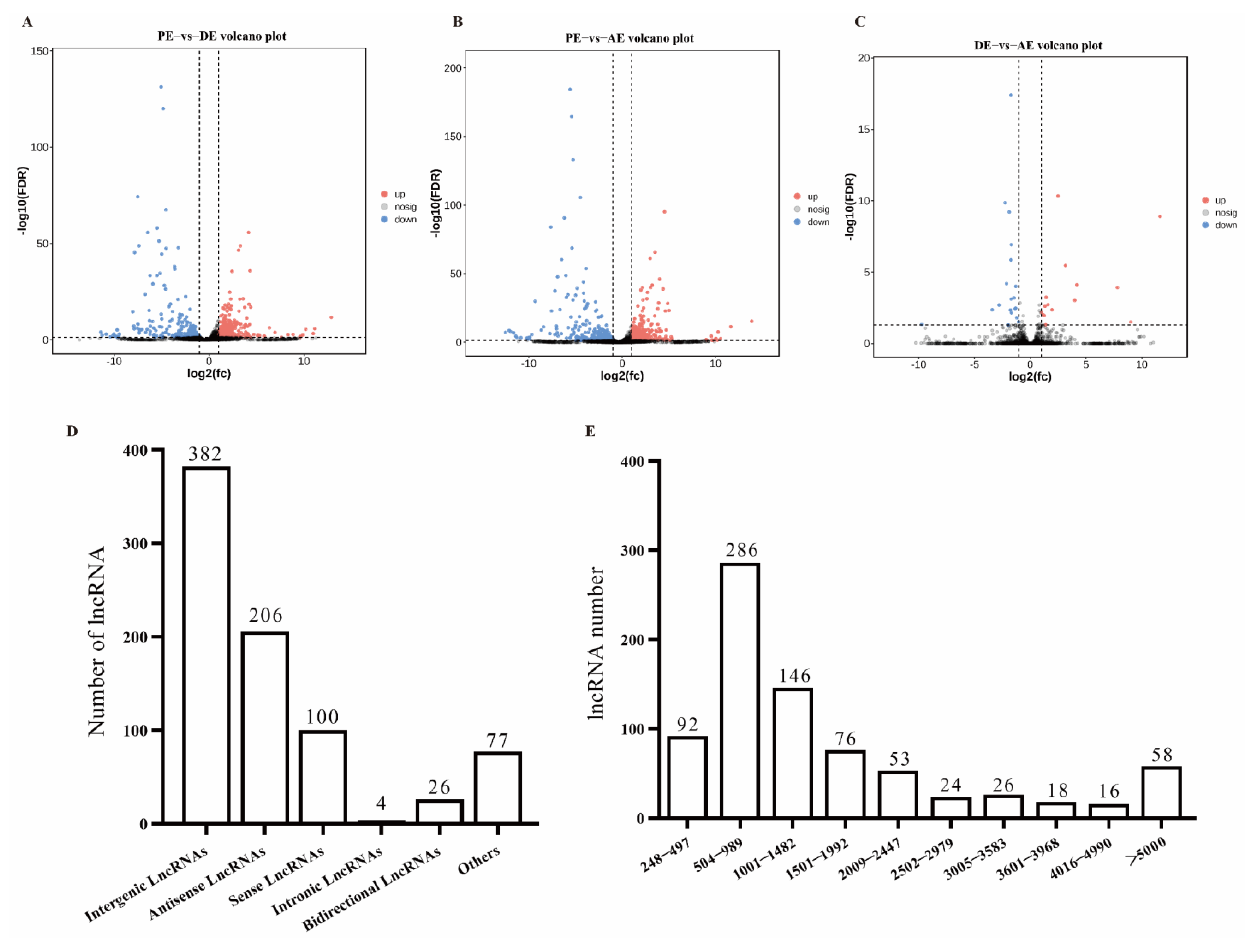
Figure 2. Analysis of differentially expressed lncRNAs. ( A ) Volcanic map of differentially expressed lncRNAs between PE and DE; ( B ) volcanic map of differentially expressed lncRNAs between PE and AE; ( C ) volcanic map of differentially expressed lncRNAs between DE and AE; ( D ) classification of differentially expressed lncRNAs; ( E ) transcript lengths of differentially expressed lncRNAs.